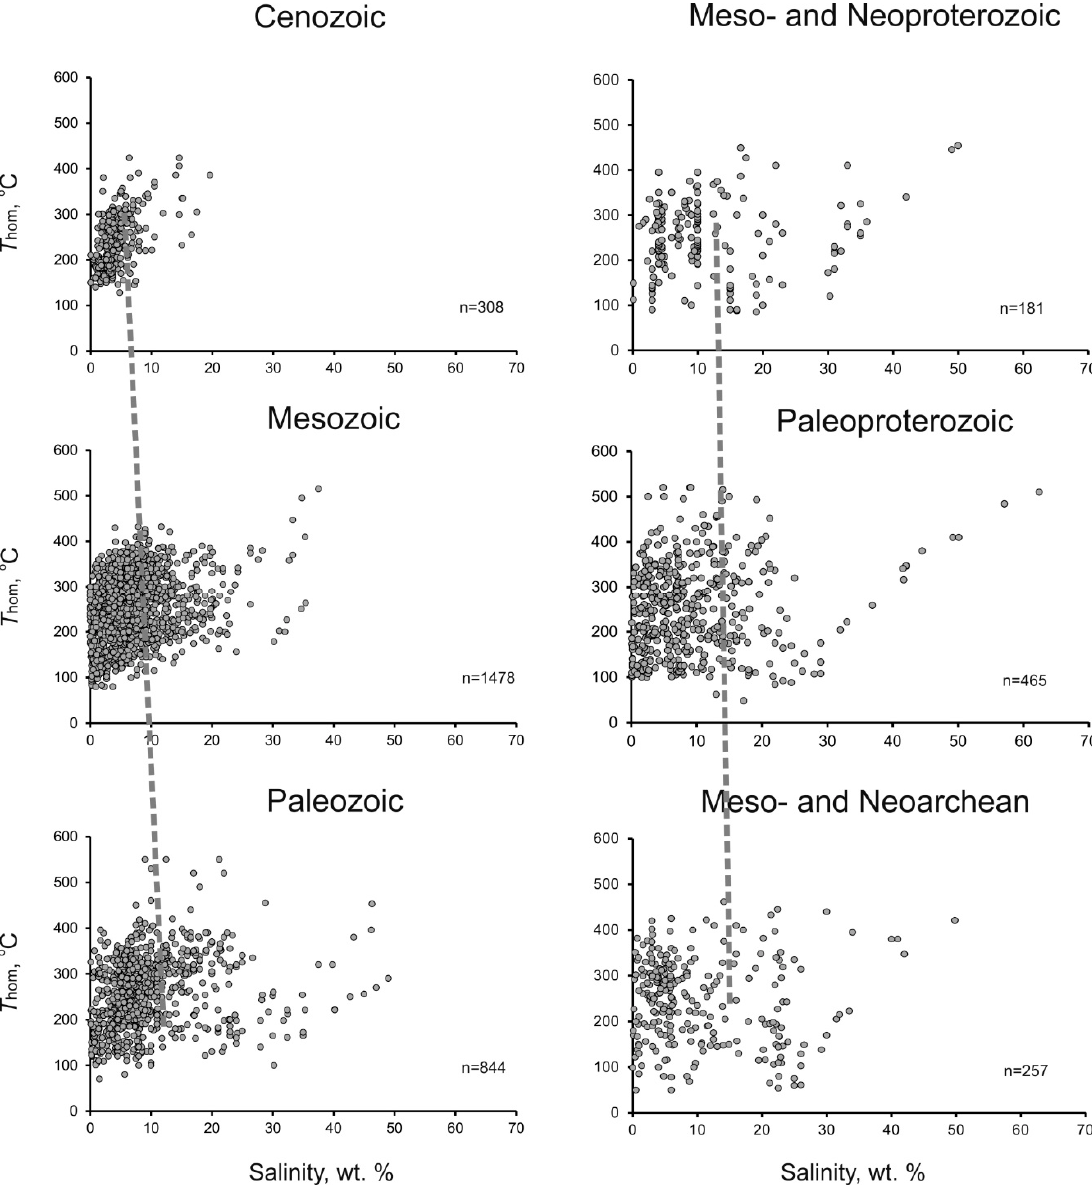
Figure 1. Temperature–salt concentration diagrams for mineralizing fluids at gold deposits of different age. Here and in Figures 2–5, n is the number of measurements. Here and on Figure 2 trendlines are shown as dashed lines. The initial data on the fluid parameters are provided as Supplementary Materials.